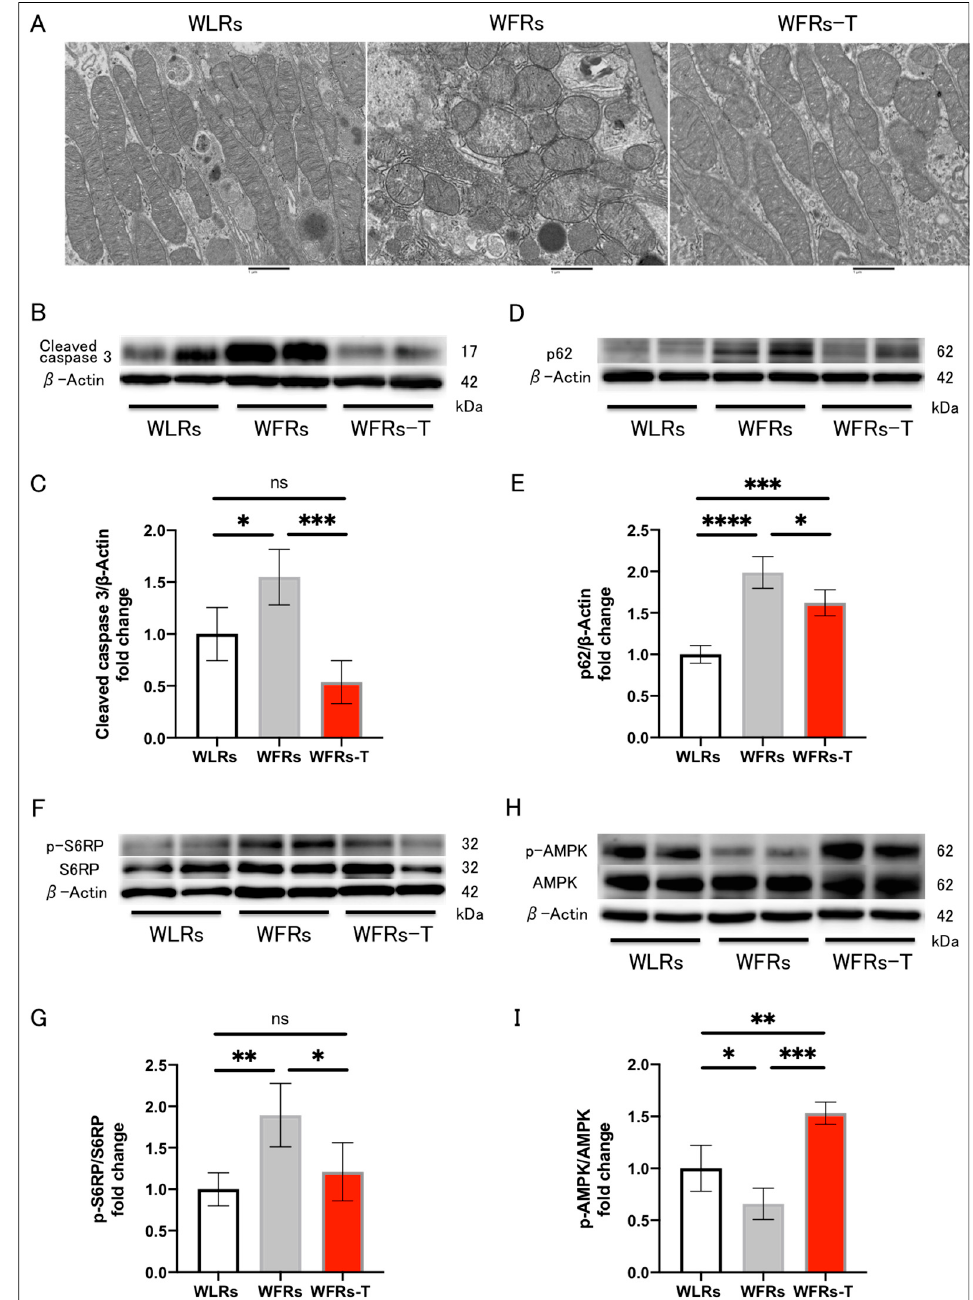
Figure 5. Changes in mitochondrial morphology, apoptosis, and autophagy in the kidney: ( A ) rep- resentative transmission electron microscopy images of proximal tubular cells (scale bar: 1 μ m); ( B ) representative immunoblots of cleaved caspase 3 and β -actin; ( C ) quantitative ratios of cleaved caspase 3 to β -actin in the renal cortex ( n = 4); ( D ) representative immunoblots of p62/SQSTM1 (p62) and β -actin; ( E ) quantitative ratios of p62 to β -actin in the renal cortex ( n = 4); ( F ) representative immunoblots of p-S6RP, S6RP, and β -actin; ( G ) quantitative ratios of p-S6RP to S6RP in the renal cortex ( n = 4); ( H ) representative immunoblots of p-AMPK, AMPK, and β -actin; and ( I ) quantitative ratios of p-AMPK to AMPK in the renal cortex ( n = 4). All data are means ± standard deviation (SD). * p < 0.05, ** p < 0.01, *** p < 0.001, **** p < 0.0001, ns: not significant. p-S6RP, phispho-S6 ribosomal protein; S6RP, S6 ribosomal protein; p-AMPK, phospho-AMP-activated kinase; AMPK, AMP-activated kinase; WLRs, sedentary Wistar lean rats; WFRs, sedentary Wistar fatty rats; WFRs-T: Wistar fatty rats with treadmill exercise